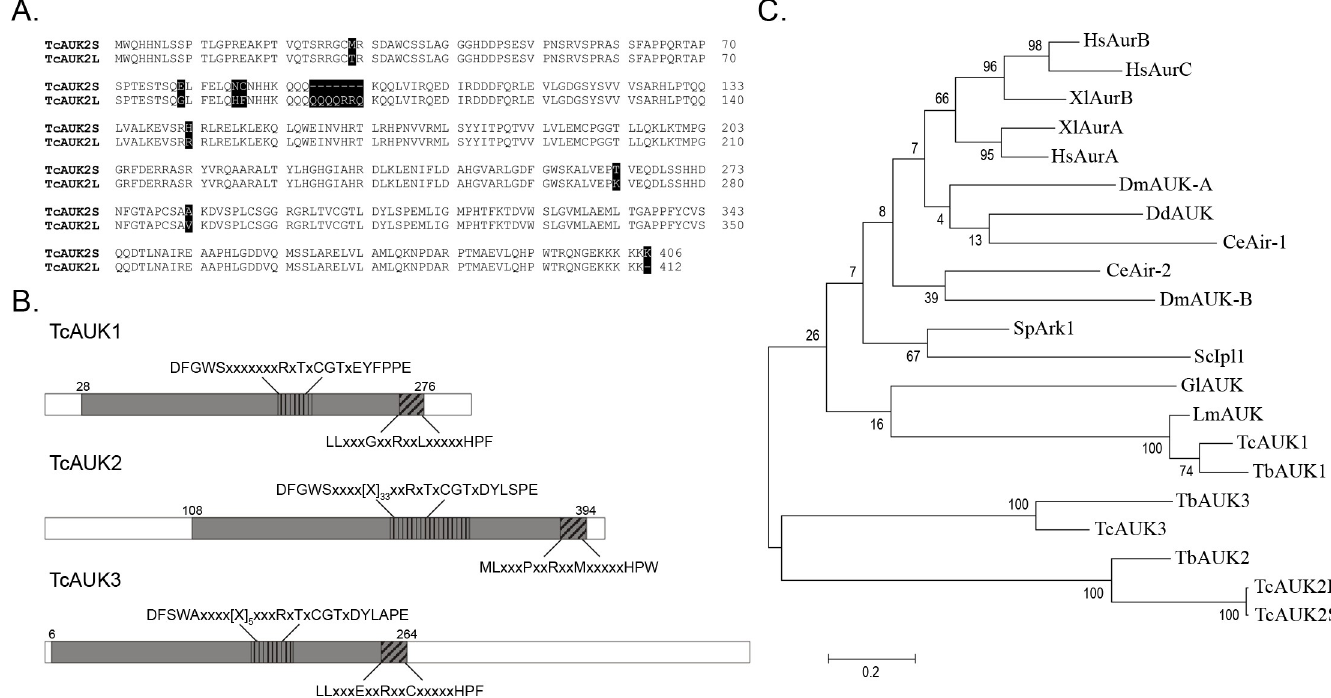
Fig 1. Sequence analysis of TcAUK proteins. (A) Pairwise alignment of deduced amino acid sequences of TcAUK2S and TcAUK2L highlighting the differences between them (black shadow). (B) Schematic representation of TcAUKs showing domain organization in TcAUK proteins. In plane grey is the kinase catalytic domain, including the highly conserved Activation loop (vertical black lines) and Destruction Box (sloping black lines). (C) Evolutionary tree constructed by the maximum parsimony method from a MSA of TcAUKs and aurora genes described for metazoans and protozoans. Hs Homo sapiens , Xl Xenopus laevis , Dm Drosophila melanogaster , Dd Dictyostelium discoideum , Ce Caenorhabditis elegans , Sp Schizosaccharomyces pombe , Sc Saccharomyses cerevisiae , Gl Giardia lamblia , Lm Leishmania major , Tb Trypanosoma brucei .